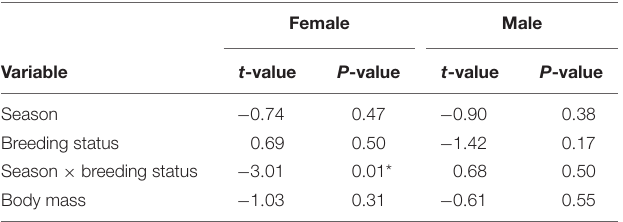
TABLE 3 | The statistical outputs of the effects of the season (non-breeding period/wet season vs. breeding period/dry season) and breeding status (breeding vs. non-breeding), their two-way interactions and body mass on the total oxidative capacity (TOS) of 31 female and 35 male highveld mole-rats ( Cryptomys hottentotus pretoriae